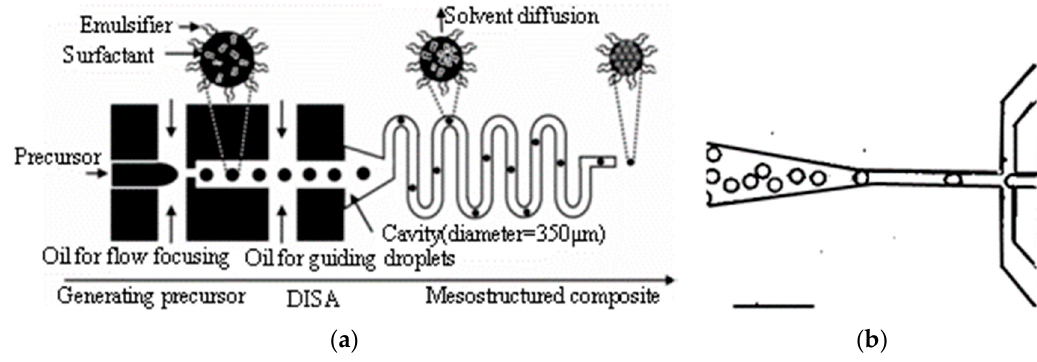
Figure 3. ( a ) Schematic illustration of the synthesis of OMS particles using microfluidic DISA used by Lee et al. [47]. Reproduced with permission from Lee, I., et al., Advanced Functional Materials ; published by John Wiley and Sons, 2008. ( b ) Optical microscopy image of droplets of the silica precursor solution emulsified in a flow focusing microfluidic device in hexadecane from Carroll et al. [74]. The channel dimensions of the orifice are 25 µ m in width and 30 µ m in length. The scale bar is 100 µ m. Reproduced with permission from Carrol, N.J., et al., Langmuir ; published by American Chemical Society, 2008.